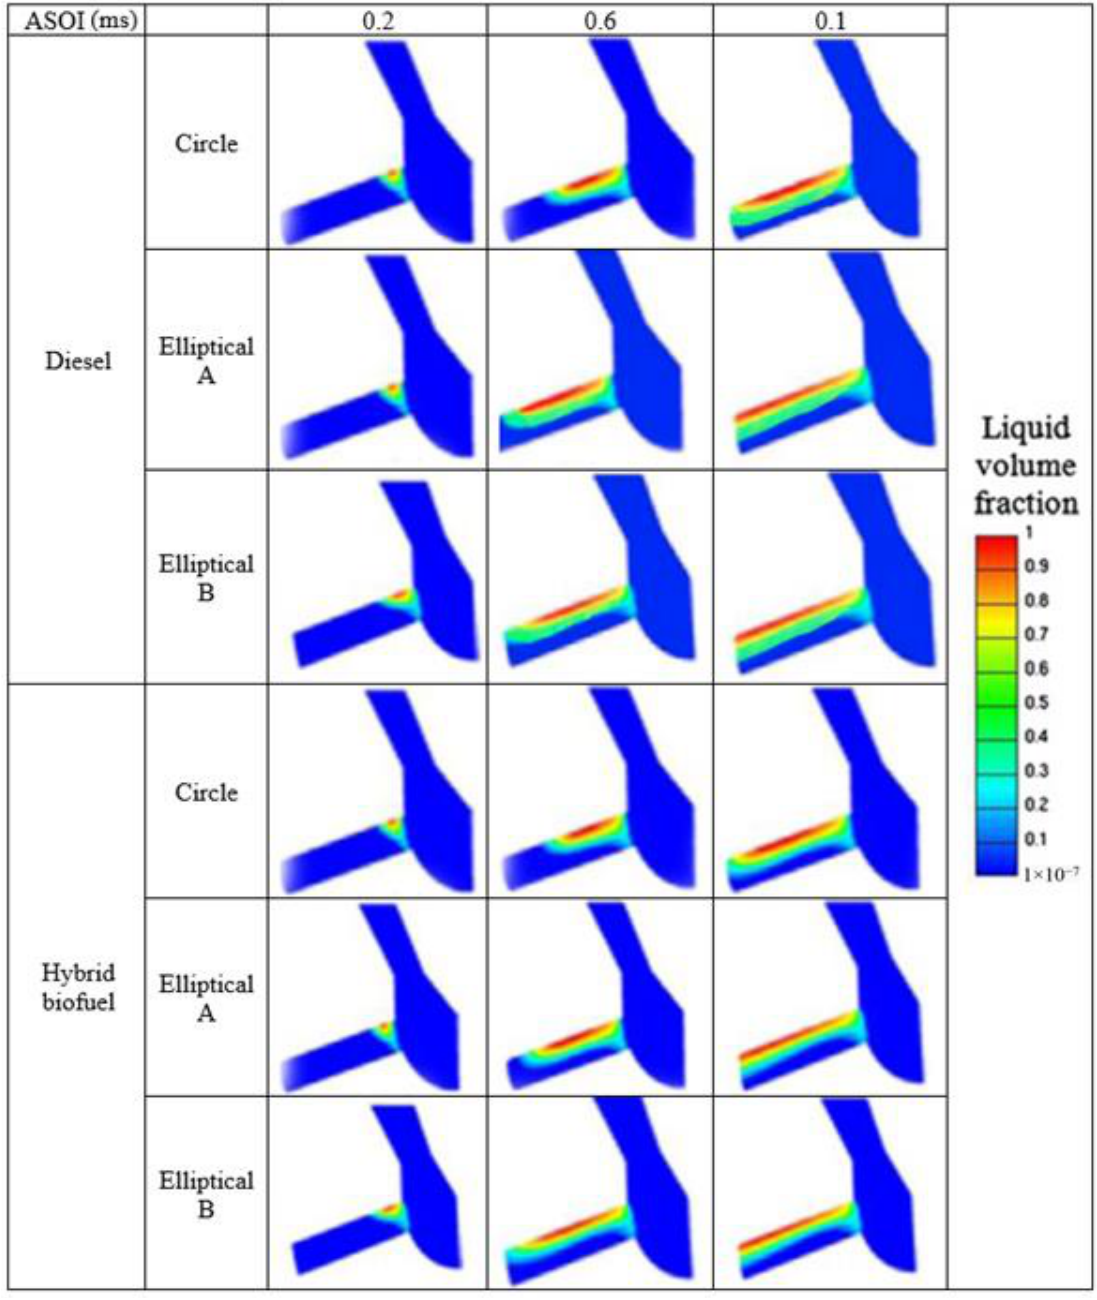
Figure 12. Cavitation in diesel nozzle for different nozzle spray shape with an injection pressure of 180 MPa.